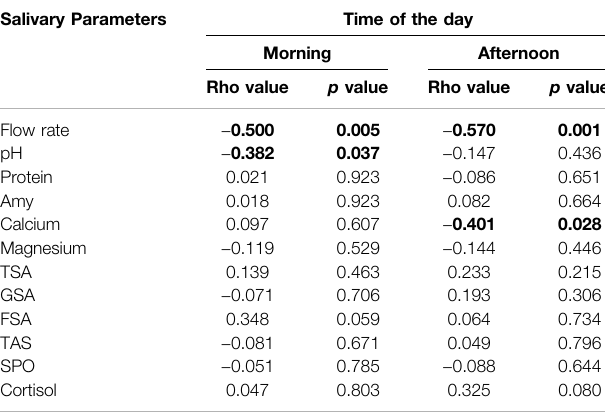
TABLE 2 | Correlation between RPE values and salivary parameters in swimmers after the morning and the afternoon training sessions. Salivary Parameters